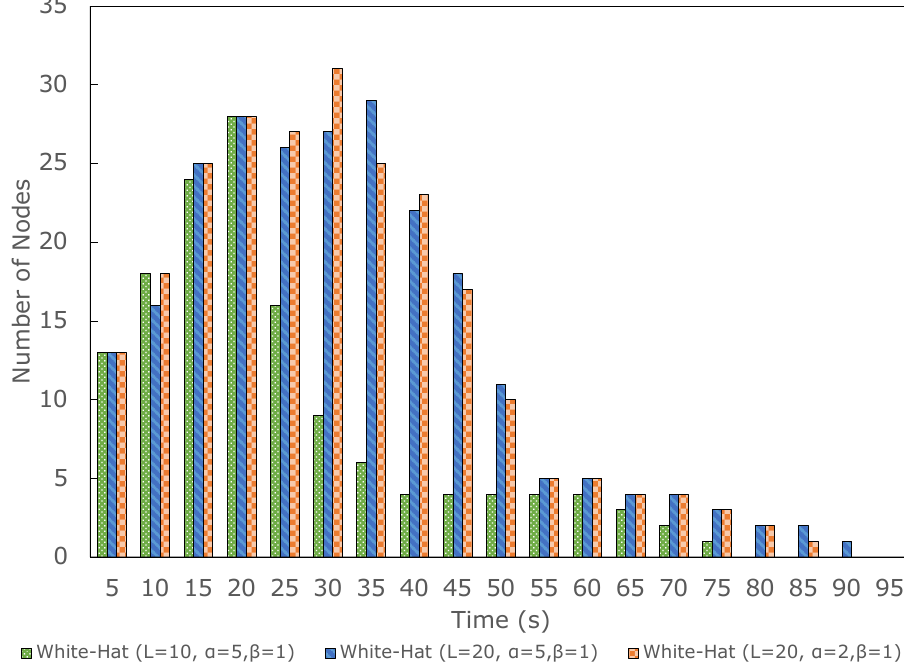
Figure 10. Comparison of the number of white-hat botnet’s successful parameter